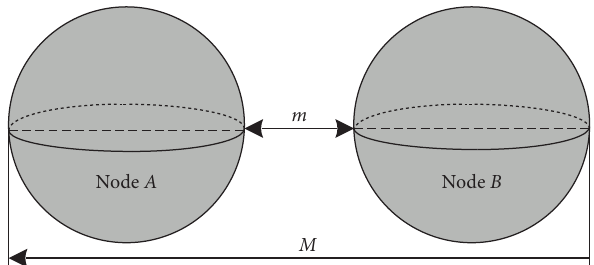
Figure 2: Distribution area of node positions of the